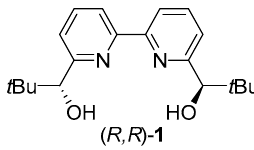
Figure 2. Bolm’s ligand ( R,R )- 1 .